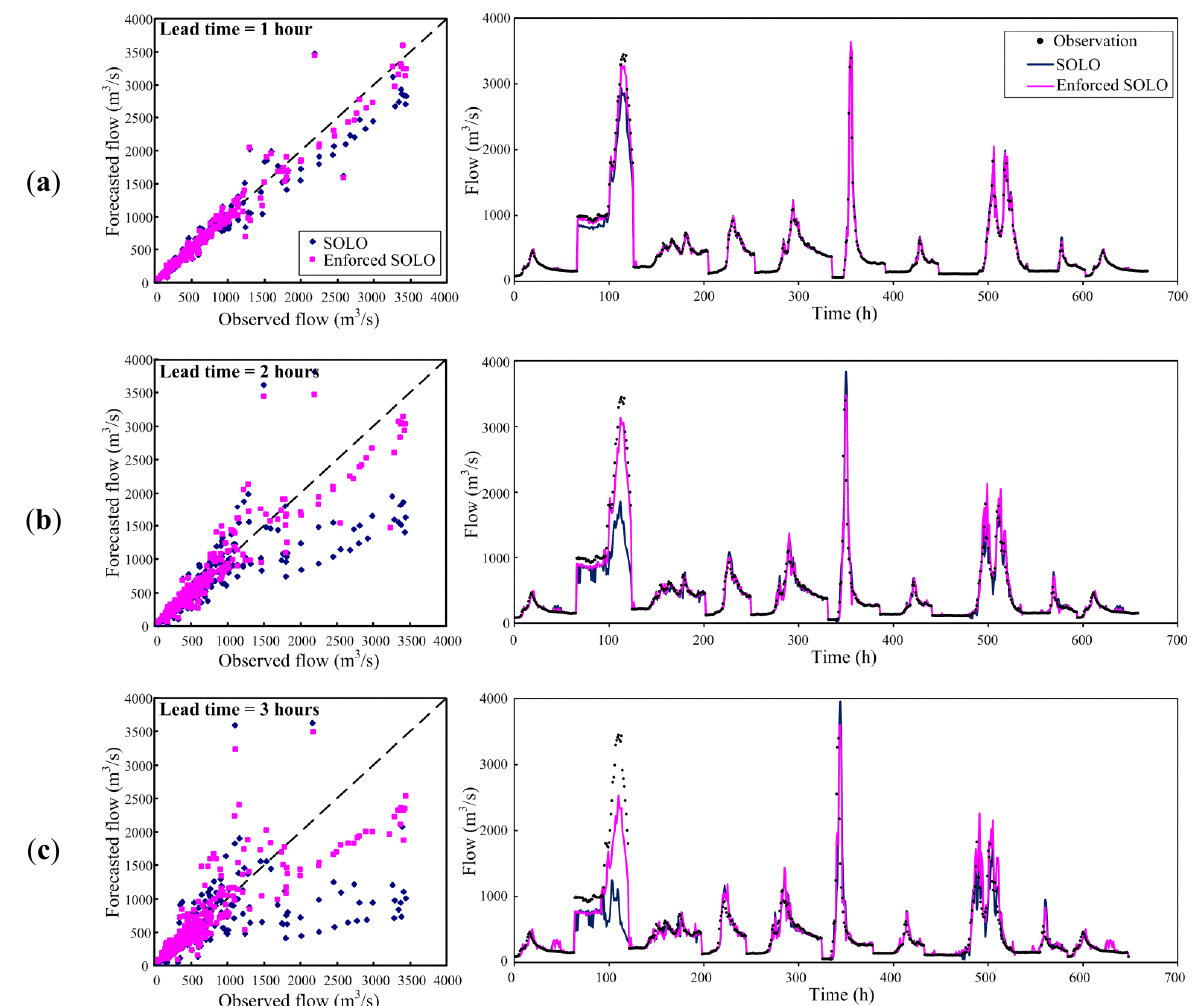
Figure 6. Observed flows versus corresponding forecasts resulting from the SOLO and the enforced SOLO models: ( a ) 1-h ahead; ( b ) 2-h ahead and ( c ) 3-h